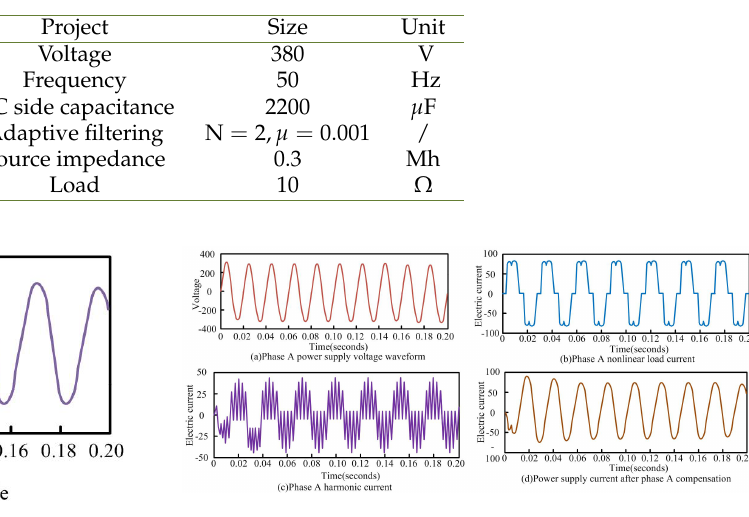
Table 1. Simulation model parameter table